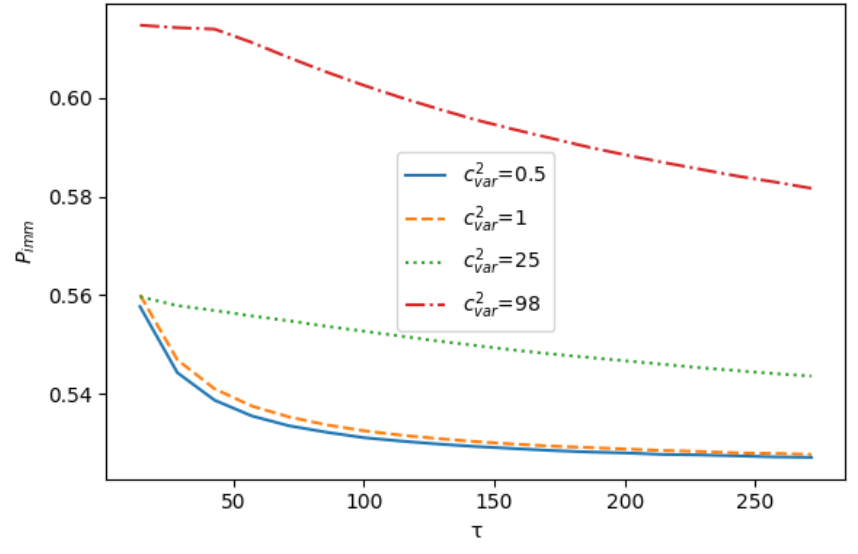
Figure 5. P imm vs. τ for the inter-retrial times with different coefficients of